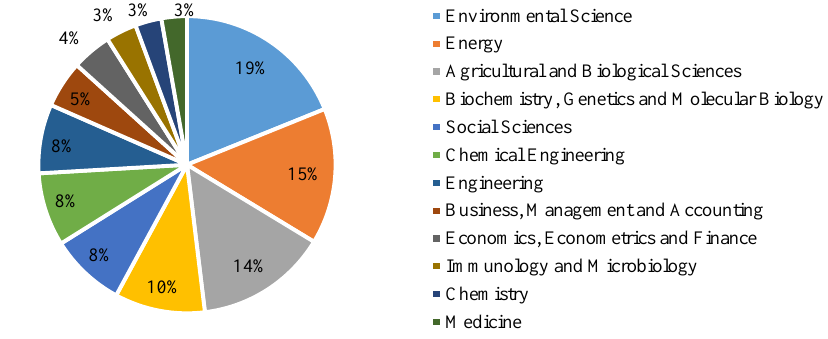
Fig. 2. Leading science sectors in which SCOPUS indexed articles on bioeconomy have been developed. The pre-selected 24 factors and their relation to the bioeconomy have been used to determine the strength and interrelation of their direct relationship. Relevant scientific publications in SCOPUS database have been selected (more than 7000), and only 24 keywords and their interlinkages have been considered. Interdisciplinary nature can be found in the analysis of the sectors in which these publications have been published. As shown in Fig. 2, the leading sectors are environmental science, energy, agriculture and biology. Other sectors are also relatively represented, showing that the bioeconomy is interlinked and has interdisciplinary